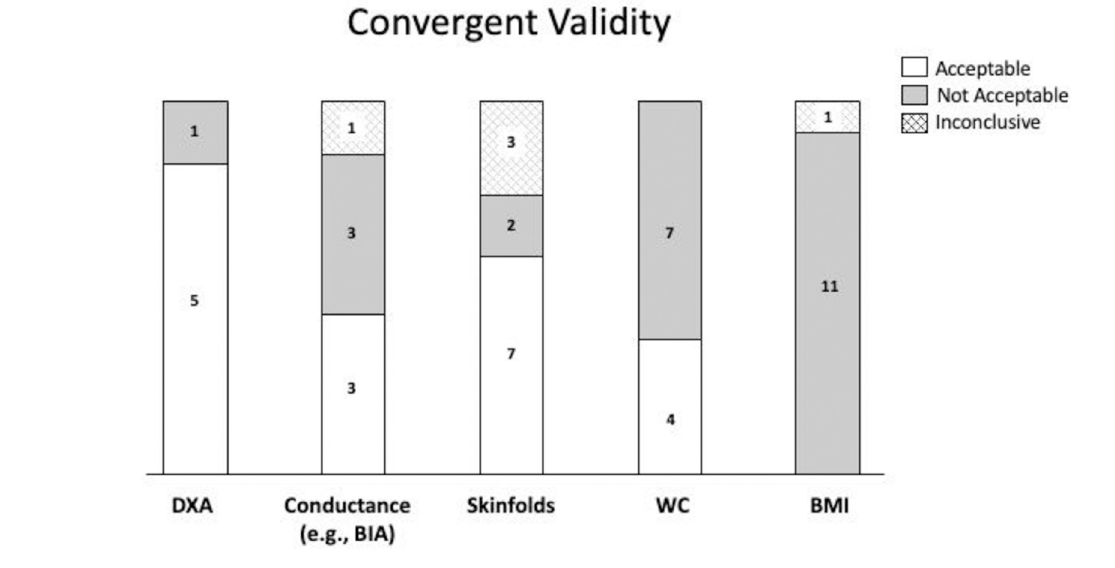
Fig 3. Number of studies with “acceptable” convergent validity (e.g. reported ICC > 0.70), that were “not acceptable” (e.g. reported ICC < 0.70), or “inconclusive” (e.g. reported statistics incomplete) for each of the most commonly evaluated assessment tools (whole- body and regional studies